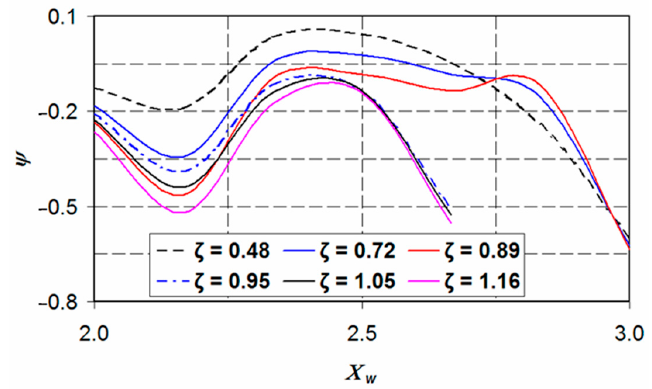
( ) ( ) Χ ψ for various values Χ ψ for various values w w